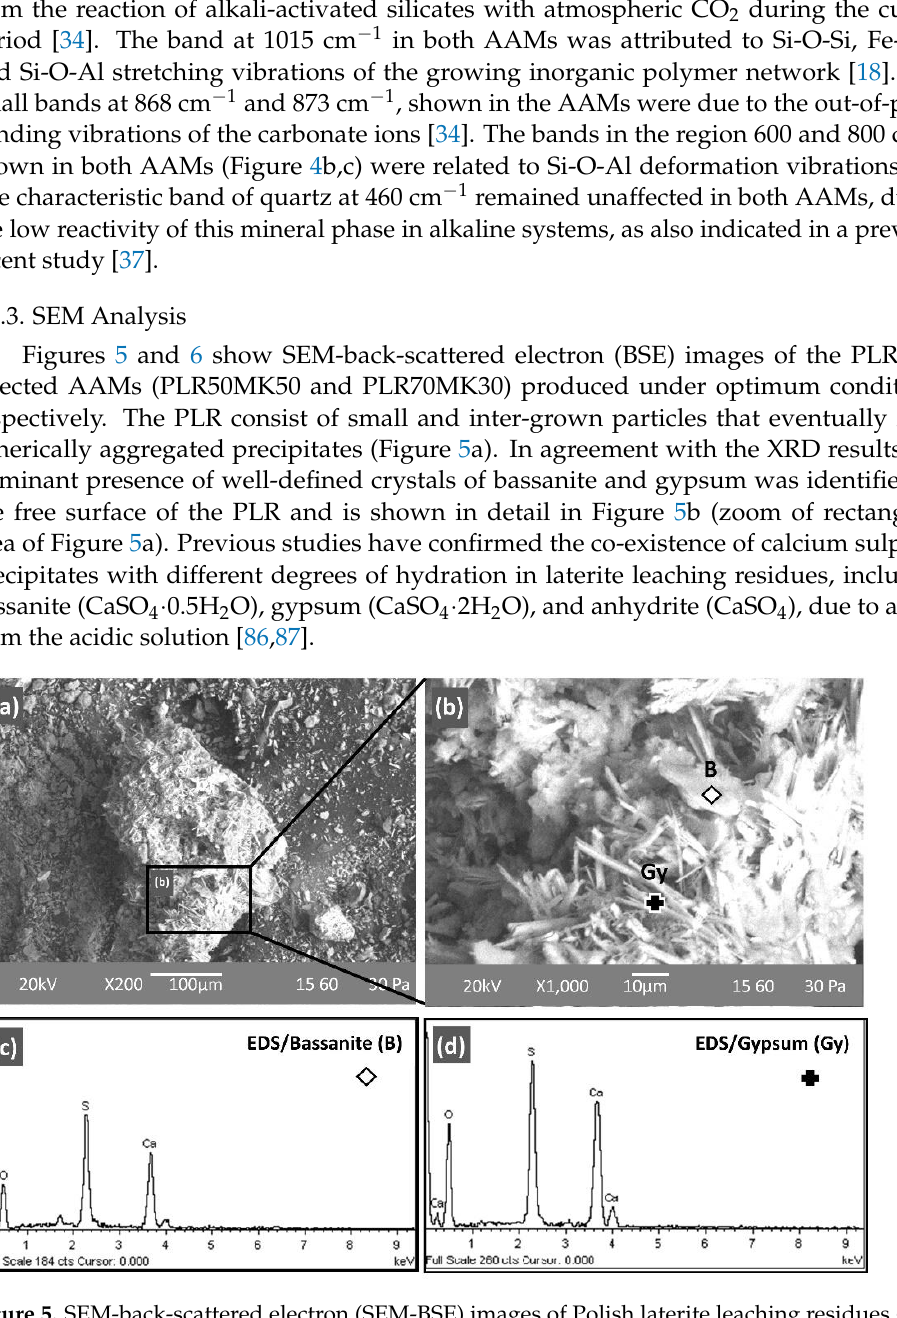
Figure 5. SEM-back-scattered electron (SEM-BSE) images of Polish laterite leaching residues (PLR) at several magnifications i.e., ( a ) × 200 and ( b ) × 1000. Energy dispersive X-ray spectroscopy (EDS) spectra at 1000 indicated the presence of ( c ) bassanite and ( d ) gypsum in the form of rosettes and prismatic crystals, respectively.